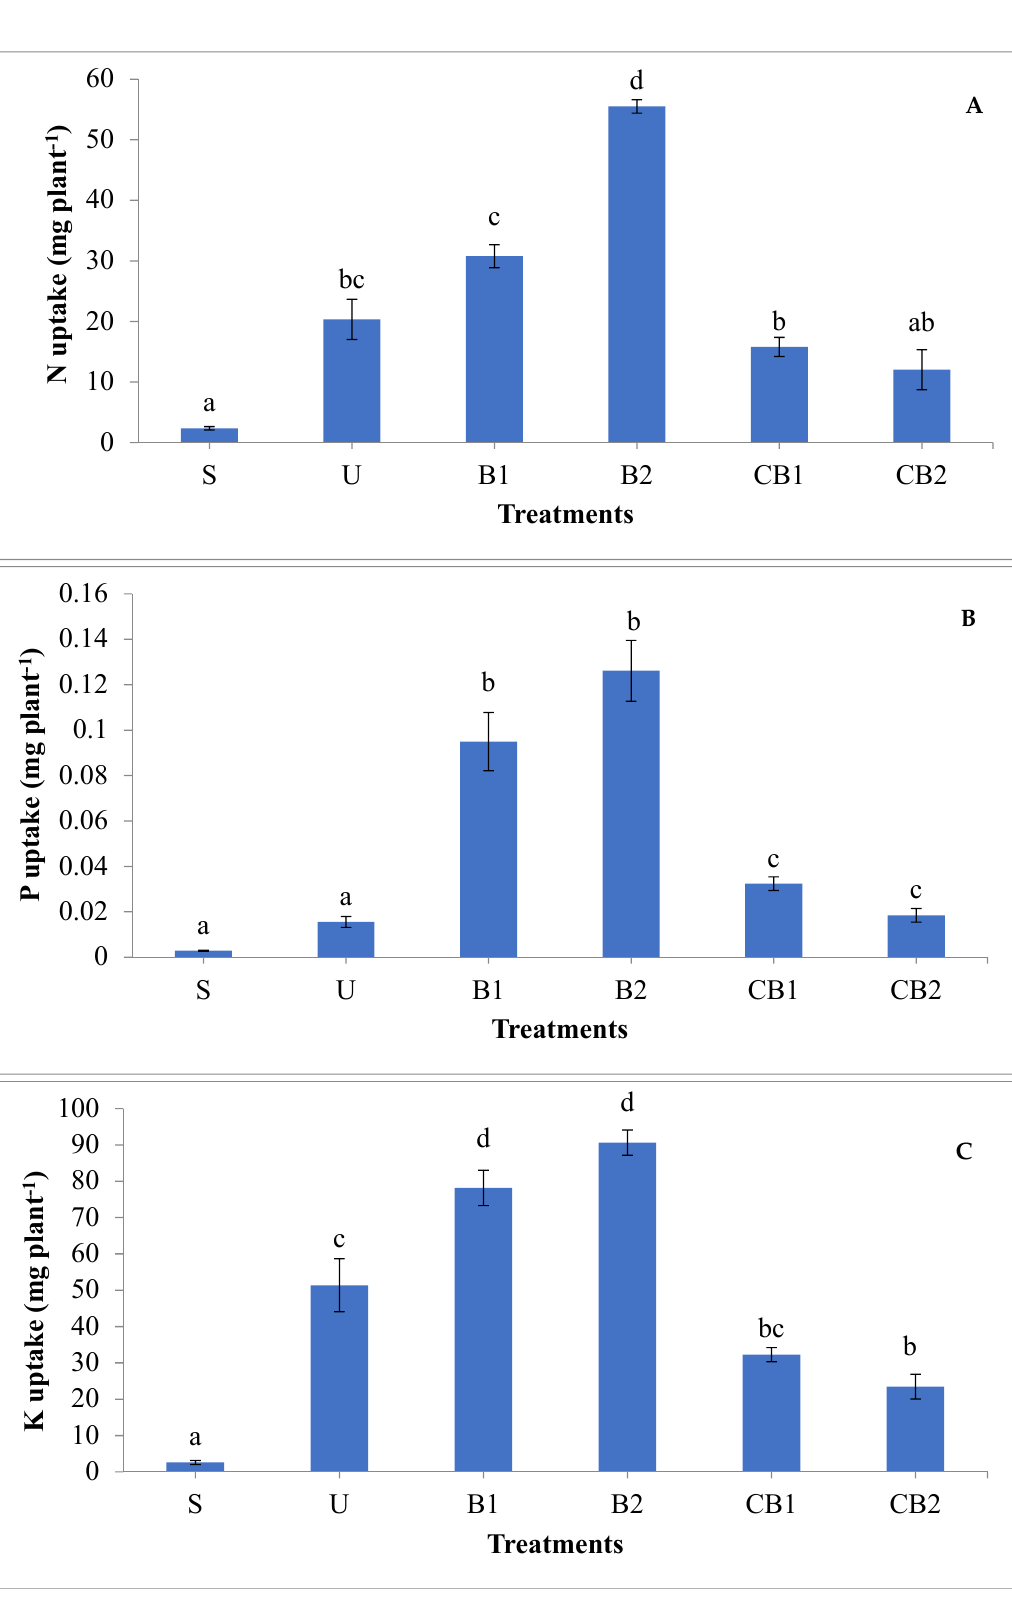
Figure 3. Effect of amending rice straw biochar on ( A ) N, ( B ) P, and ( C ) K uptake of rice plants. Mean values with different letter(s) indicate significant difference between treatments by Tukey’s test at p ≤ 0.05. Bars represent the mean values ± SE. The treatments evaluated were: S: Soil only, U: Soil + 175 kg ha − 1 urea, B1: Soil + 175 kg ha − 1 urea + 5 t ha − 1 rice